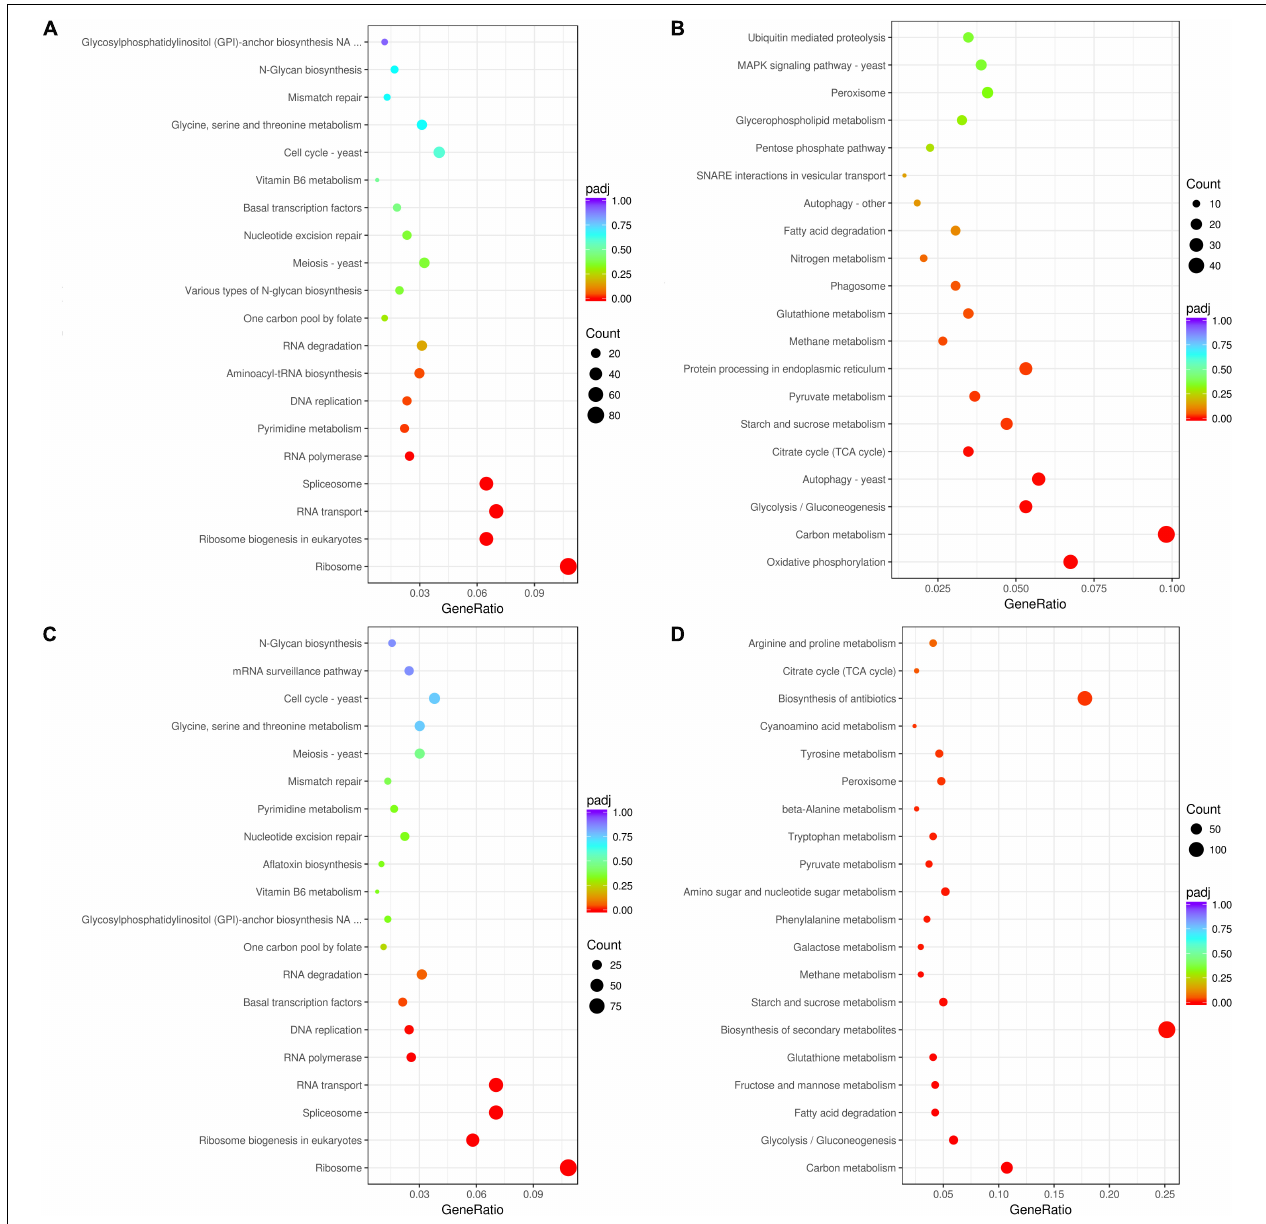
FIGURE 3 | KEGG enrichment of down-regulated (A,C) and up-regulated (B,D) DEGs. (A,B) The ordinate means with 2.5% ethanol treatment. (C,D) The ordinate means with 3.5% ethanol treatment. The size of the plot represents the number of DEGs in one GO term; the color of the plot close to red represents more significant